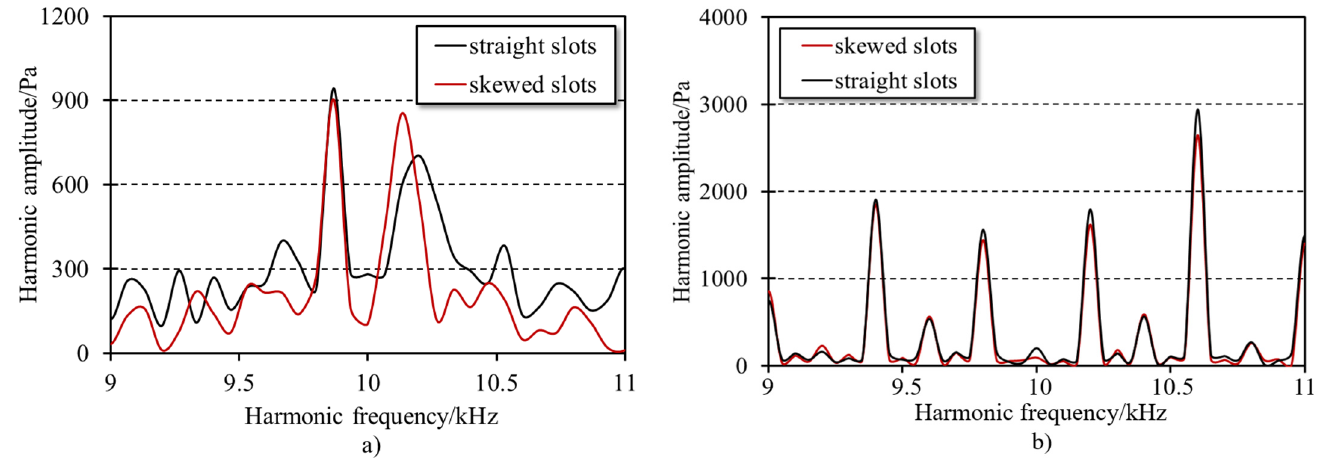
Figure 9. Time spectrogram of the excitation force of two motors: ( a ) when the speed is 1000 rpm; ( b ) when the speed is 3000 rpm. Table 5. Amplitude of excitation force obtained by one-dimensional Fourier decomposition